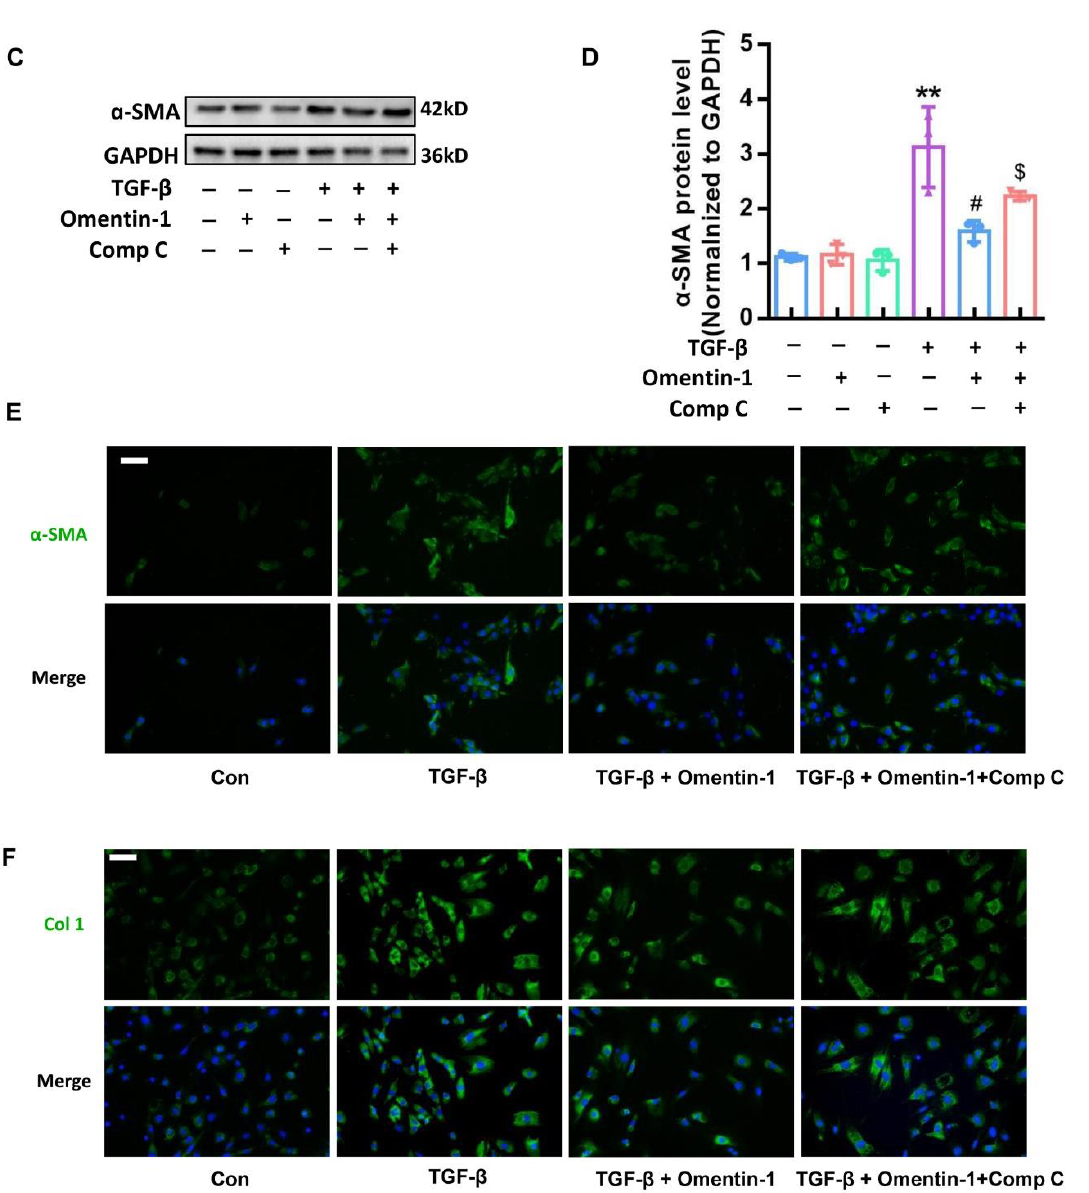
Figure 7. The effect of omentin-1 mediated by activation of AMPK pathway in vitro. ( A ) The content of p-AMPK, AMPK in mouse lung fibroblasts detected by Western blotting with cropping gel at the relative molecular size ( n = 3). Cells were treated with omentin-1 (500 ng/mL) for 15, 30, 45, 60, 120 min; ( B ) Semi-quantitative analysis of p-AMPK/AMPK level evaluated by Western blotting with cropping gel at the relative molecular size. ( C ) The content of α-SMA in mouse lung fibroblasts detected by Western blotting ( n = 3). Cells were pretreatment with Comp C (10 µ M) for 1 h, then treated with omentin-1 (500 ng/mL) for 1h, then treat with TGF- β (10 ng/mL) for 48 h; ( D ) Semi- quantitative analysis of α -SMA level evaluated by Western blotting. ( E ) Immunofluorescence for α -SMA in mouse lung fibroblasts (Bar = 50 µ m, n = 3). ( F ) Immunofluorescence for Col1 in mouse lung fibroblasts (Bar = 50 µ m, n = 3). The data are presented as the mean ± SD. * p < 0.05, ** p < 0.01 vs. control group. # p < 0.05 vs. TGF- β group, $ p < 0.05 vs. TGF- β +Omentin-1